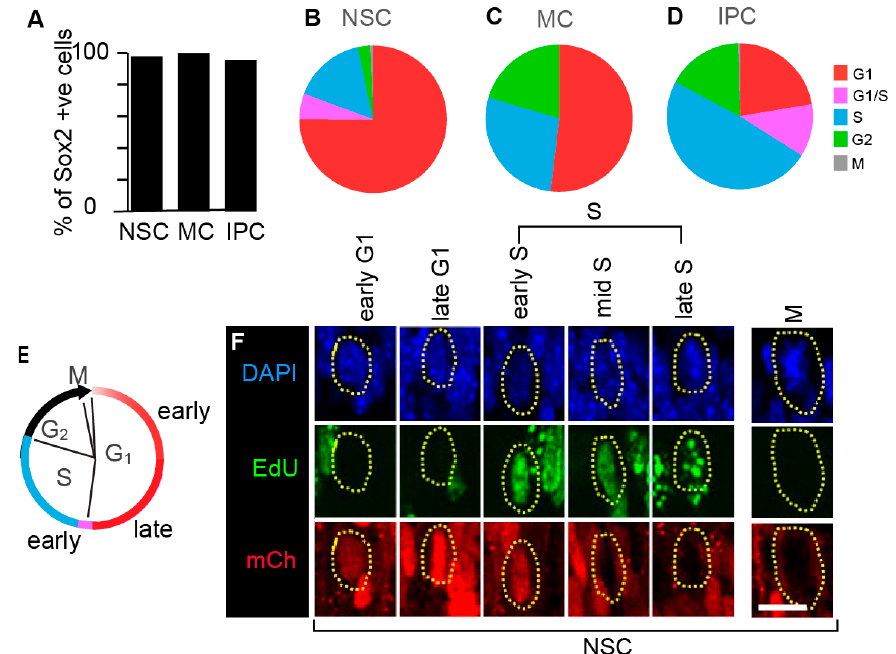
Figure 3. Cell cycle phase distributions in the populations of the three neural precursor cell types of the OE. ( A ) We counted Sox2 positive cells in each position, then quantified the percentage of these cells that were also co-labelled with one or more probes detecting EdU, mCherry-hCdt1 (30/120), and mVenus-hGem (1/110). NSCs—apical position (n = 859). MCs—between the apical and basal domains and not touching either domain (n = 54). IPCs—basal position (n = 324). ( B – D ) The cell cycle phase distributions in the populations. ( B ) NSCs are predominantly in G1 (n = 841). ( C ) MCs are intermediate between NSCs and IPCs (there were no G1/S cells detected, n = 54). ( D ) IPCs have many cells in S (n = 324). ( E ) It is possible to distinguish G1 and S phases in the precursor populations by a combination of mCherry-hCdt1 (30/120) and EdU injection. The color code is as in panels ( B – D ). ( F ) Labelling of NSCs in different cell cycle phases by a combination of mCherry-hCdt1 (30/120) and EdU. With this IHC protocol, we can clearly distinguish the G1 phase and S phase in the precursors in situ